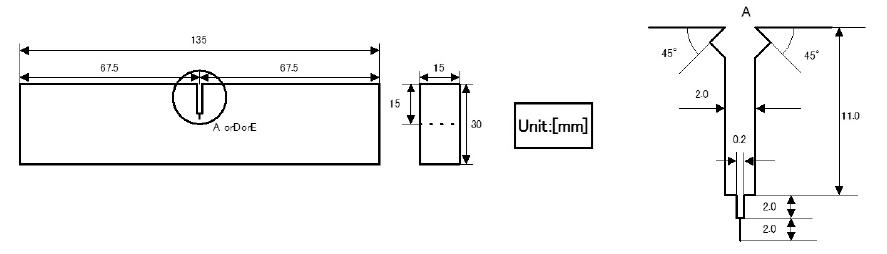
Figure 3. CTOD testing environment.